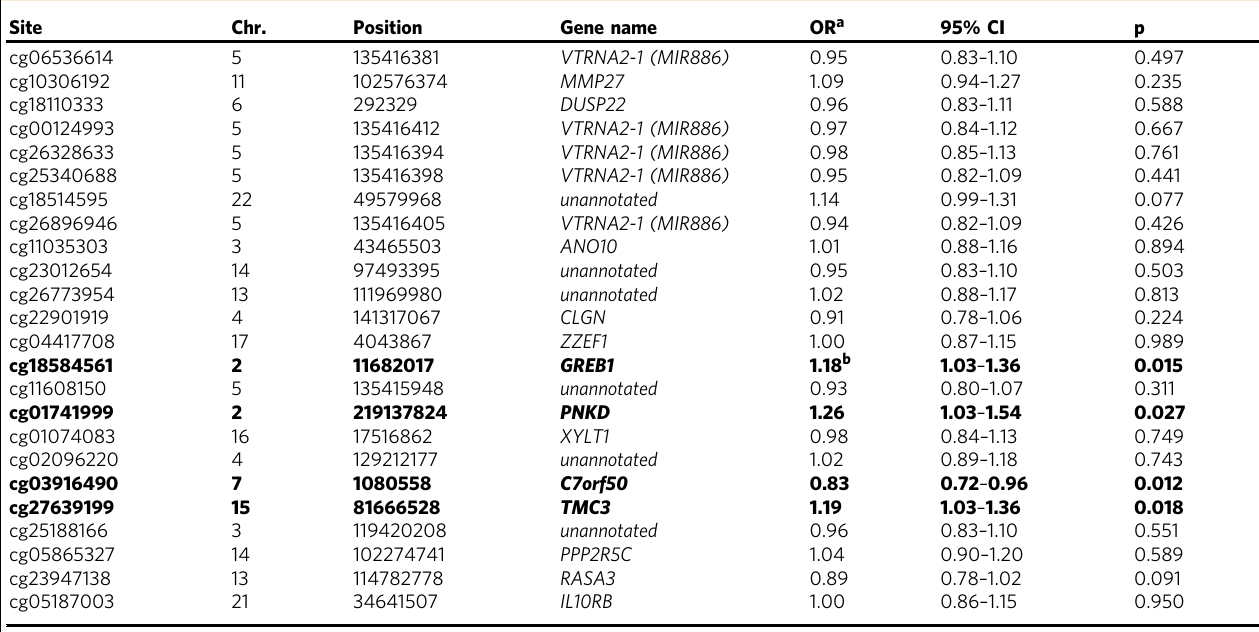
Table 2 Associations between heritable DNA methylation marks (associated with breast cancer in multiple-case families) and risk of breast cancer in the general population (Melbourne Collaborative Cohort Study) Site